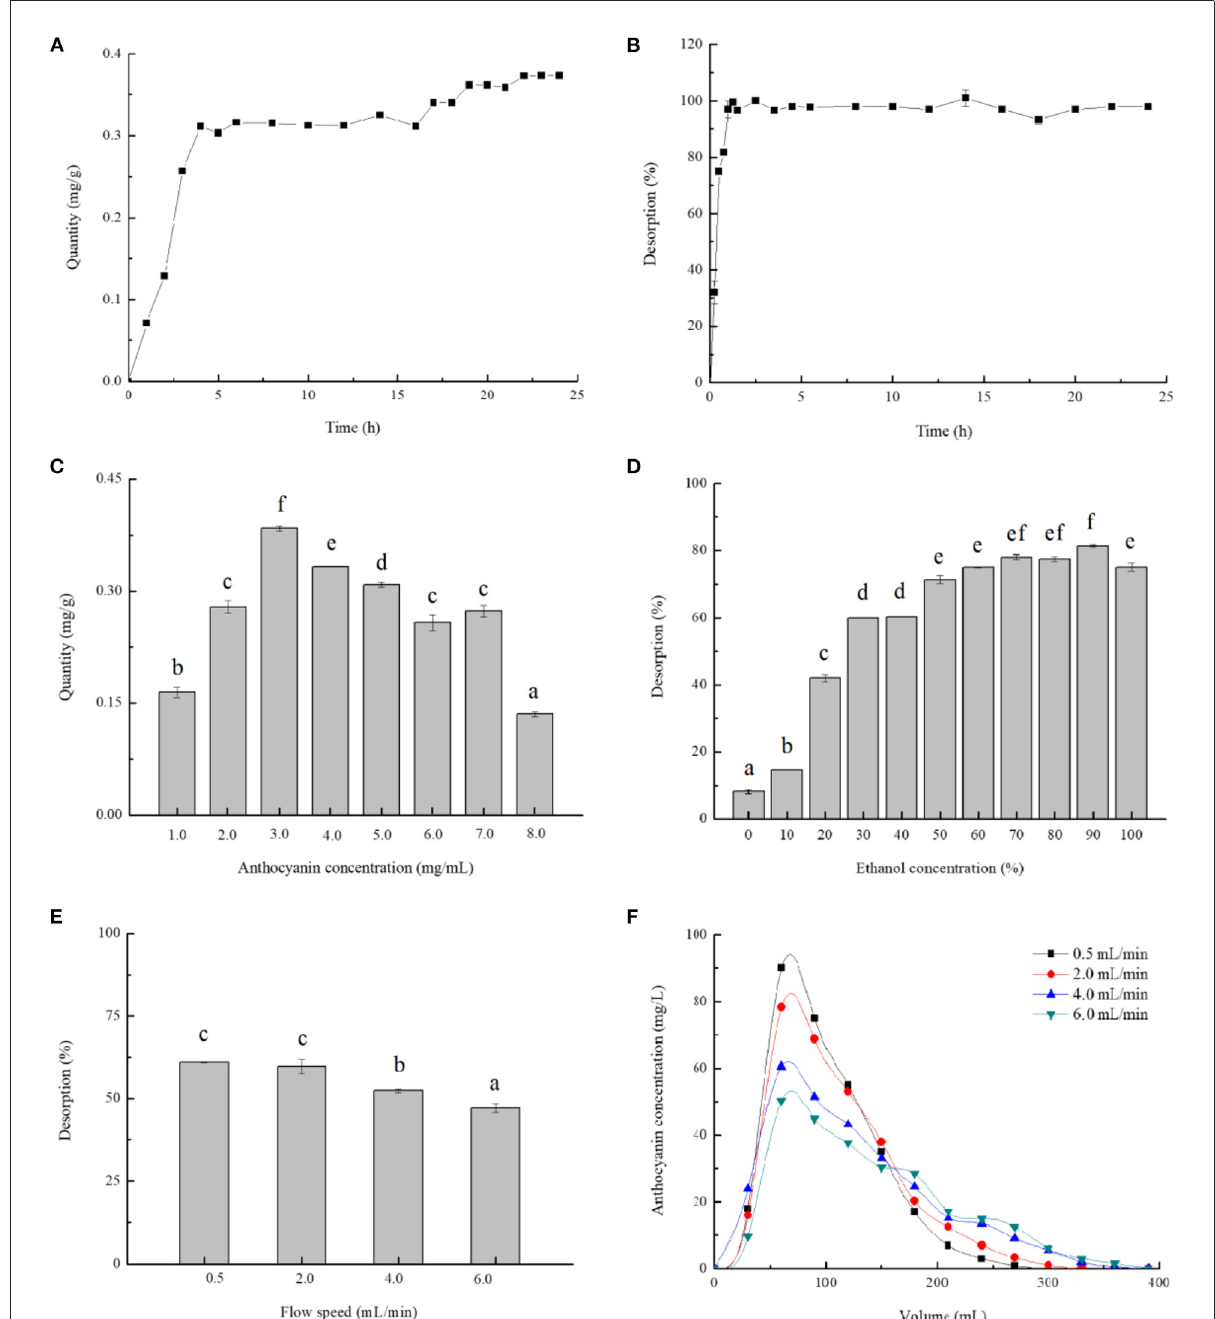
FIGURE3 Single-factor analysis of blackberry anthocyanin purification. The adsorption kinetics (A) and desorption kinetics (B) were plotted, and the effects of different purification parameters: Anthocyanin concentration in sample (C) , ethanol concentration (D) , and flow speed (E,F) on absorption quantity or desorption rate were also studied. The mean values in the same figure with different lowercase letters were significantly different at the level of 0.05.